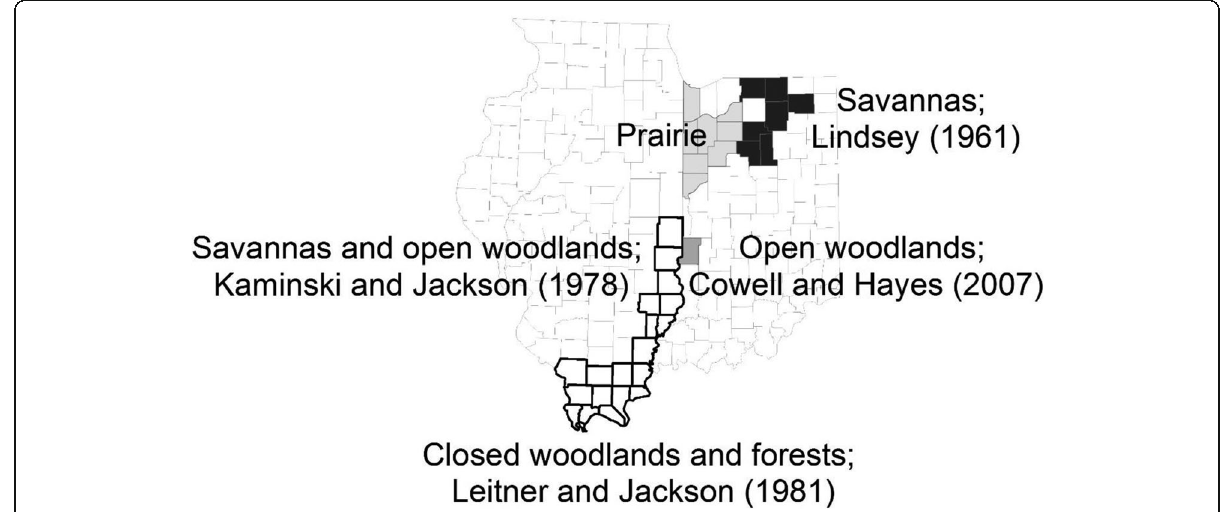
Fig. 2 Approximate location and extent of studies that estimated historical densities in Indiana and adjacent